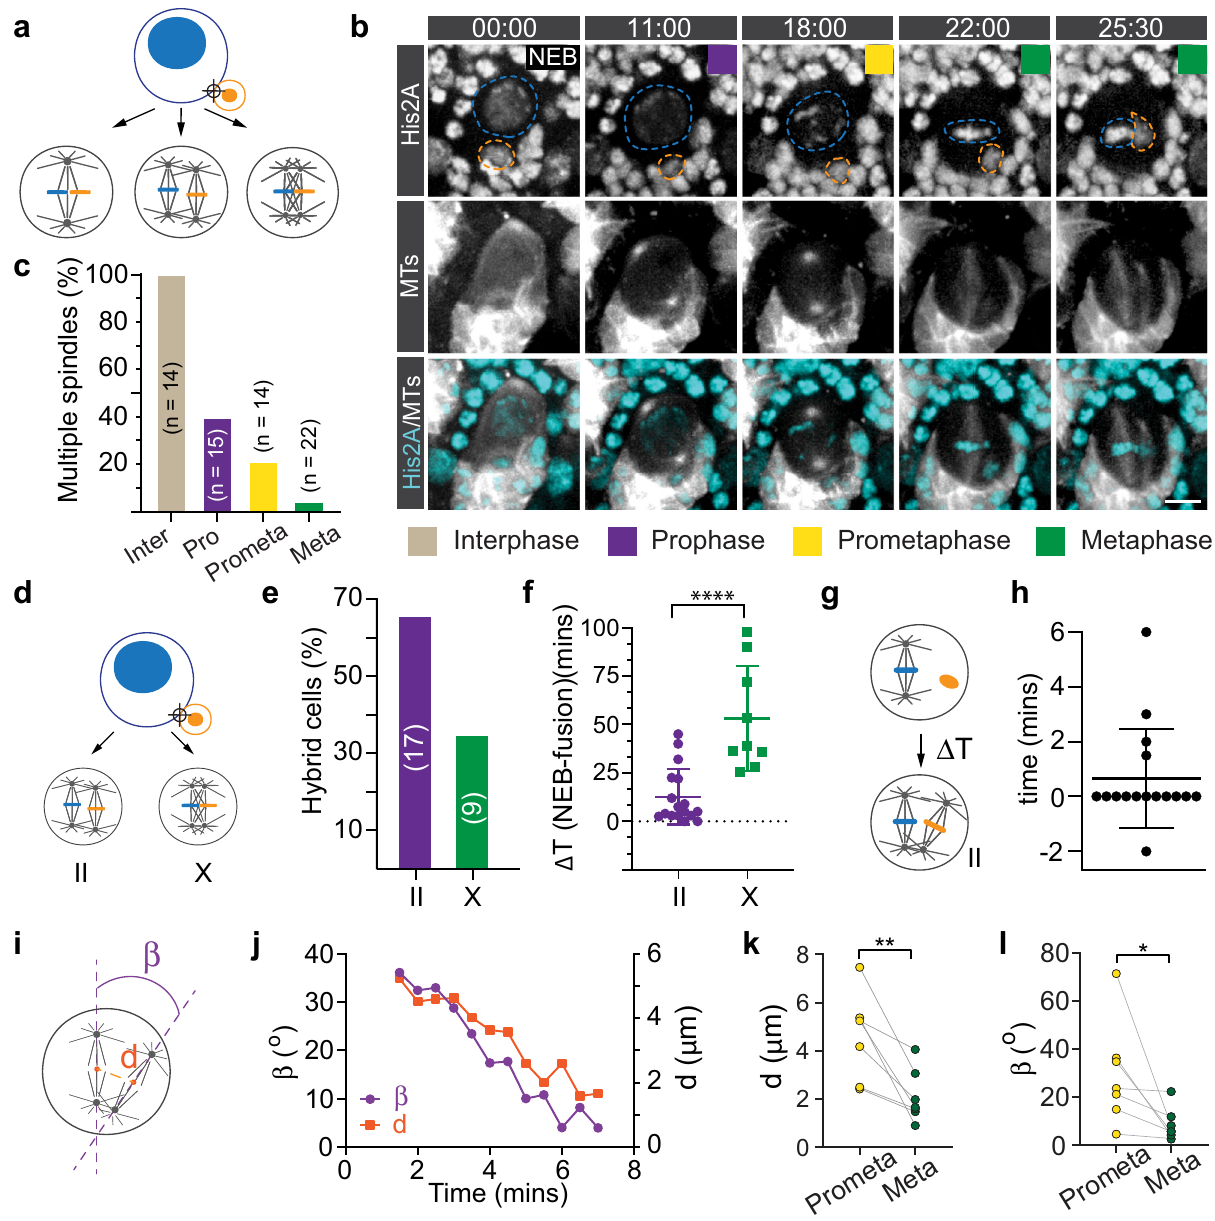
Fig. 2 Dual spindles align endogenous and ectopic spindles separately at the metaphase plate. a Hypothetical outcomes of spindle organization after NB-GMC fusions: hybrid cells could align neuroblast and GMC chromosomes either through a single or dual-spindle mechanism. b Representative third instar larval NB-GMC hybrid cell, expressing the histone marker His2A::GFP (white in top row; cyan in merged channel below) and the MT marker cherry::Jupiter (white in middle and bottom row). 00:00 refers to the start of nuclear envelope breakdown (NEB). NB- and GMC-derived chromatin is outlined with a blue and orange dashed line, respectively. c Quanti fi cation of hybrid cells containing dual- or multiple spindles for hybrid cells derived from interphase (inter), prophase (pro), prometaphase (prometa) or metaphase (meta) fusions. d Hybrid cells either form clearly distinct parallel (II) or interconnected (X) spindles, quanti fi ed in e . f Time difference between NEB and fusion induction for parallel and interconnected spindles. g For hybrid cells with parallel spindles, the time difference between endogenous and ectopic spindle formation was measured and plotted in h . i For hybrid cells with parallel spindles, spindle angle and inter-spindle distances were measured during mitosis. A representative example is shown in j . Quanti fi cation of inter-spindle k distances and l angles at prometaphase and metaphase. Colored boxes represent corresponding cell cycle stages. Error bars correspond to SDs. Unpaired t-test was used in Fig. 2f, n. Two-sided paired t-test was used in Fig. 2k, l. * p < 0.05, ** p < 0.01, **** p < 0.0001. Time in min:sec. Scale bar is 5 μ